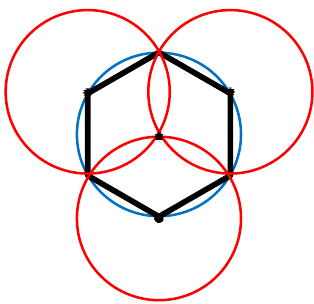
Figure 4. A schematic diagram of the node deployment for a single cellular grid.